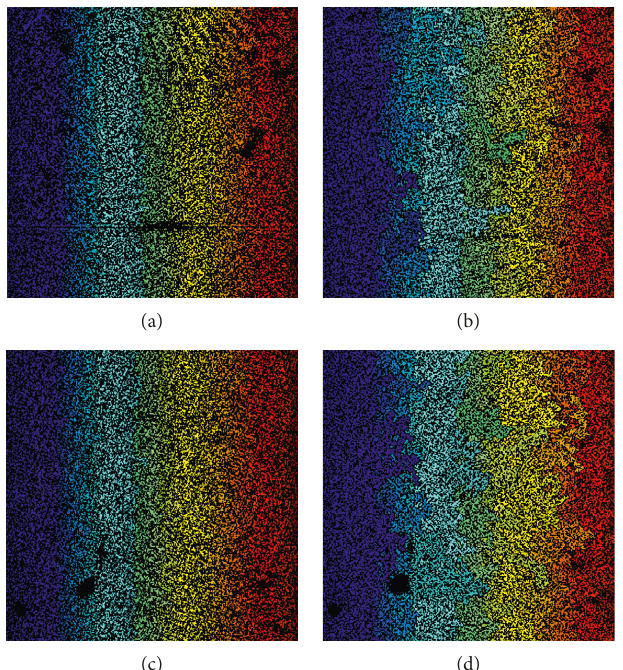
Figure 7: The distribution of the connected group of anthracite with a diameter of 2.54mm after modification. (a) Unmodified anodic zone, (b) modified anodic zone, (c) unmodified cathodic zone, and (d) modified cathodic